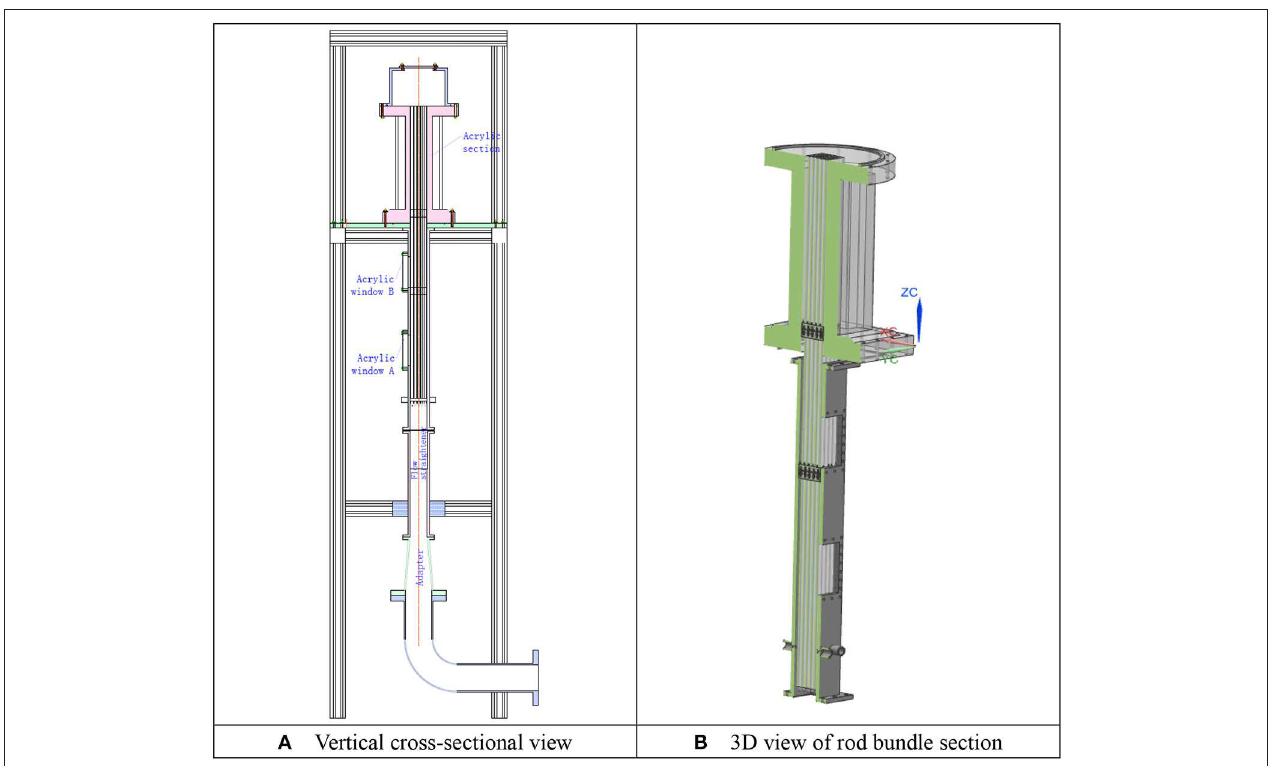
FIGURE 2 | Geometry of the rod-bundle test section. (A) Vertical cross-sectional view. (B) 3D view of rod bundle section.